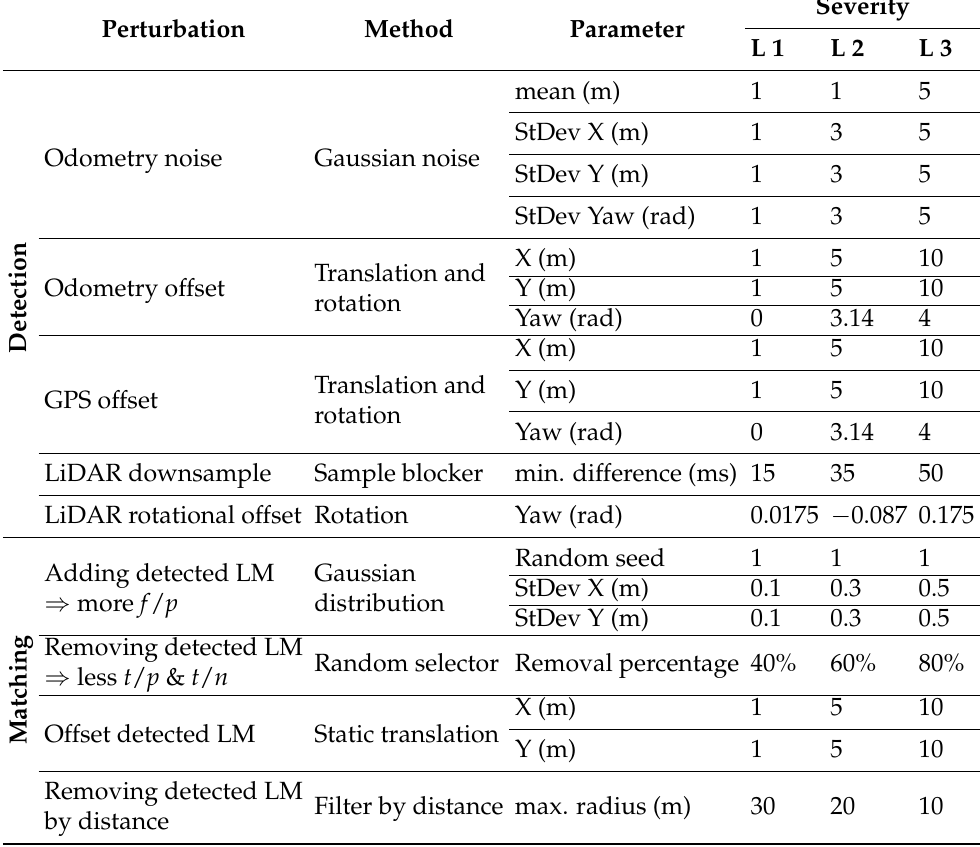
Table 3. List of used injections for perturbations p with altered parameters in the localization system and values for the three severity levels s